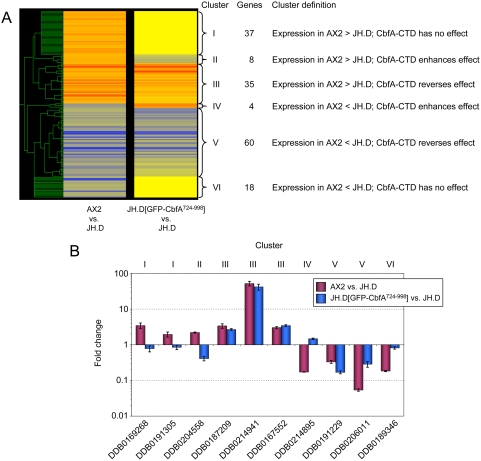
Gene regulatory effects of CbfA-CTD.(A) Left column: presentation of microarray data of 162 CbfA-regulated genes as defined by comparison of AX2 with JH.D. The colors represent the fold change (red: expression AX2>JH.D; blue: AX2<JH.D). Right column: expression of 162 CbfA-regulated genes in JH.D cells expressing GFP-CbfA724–998 vs. JH.D (red: expression JH.D[GFP-CbfA724–998]>JH.D; blue: JH.D[GFP-CbfA724–998]<JH.D). Non-regulated genes are displayed in yellow. The genes were clustered with GeneSpring 7.2. Six clusters of co-regulated genes were identified (cluster descriptions are given in the table to the right of the figure). The numbers of genes per cluster is indicated. (B) Verification of the microarray data using real-time RT-PCR of selected genes. We tested 2–3 representative genes for clusters that contained ≥10 genes and one gene for clusters with ≤10 genes. The corresponding cluster numbers are indicated above the figure. The data set for the AX2 vs. JH.D comparison is the same as in Figure 1. The data are expressed as means of fold change±SD from three independent RNA preparations.